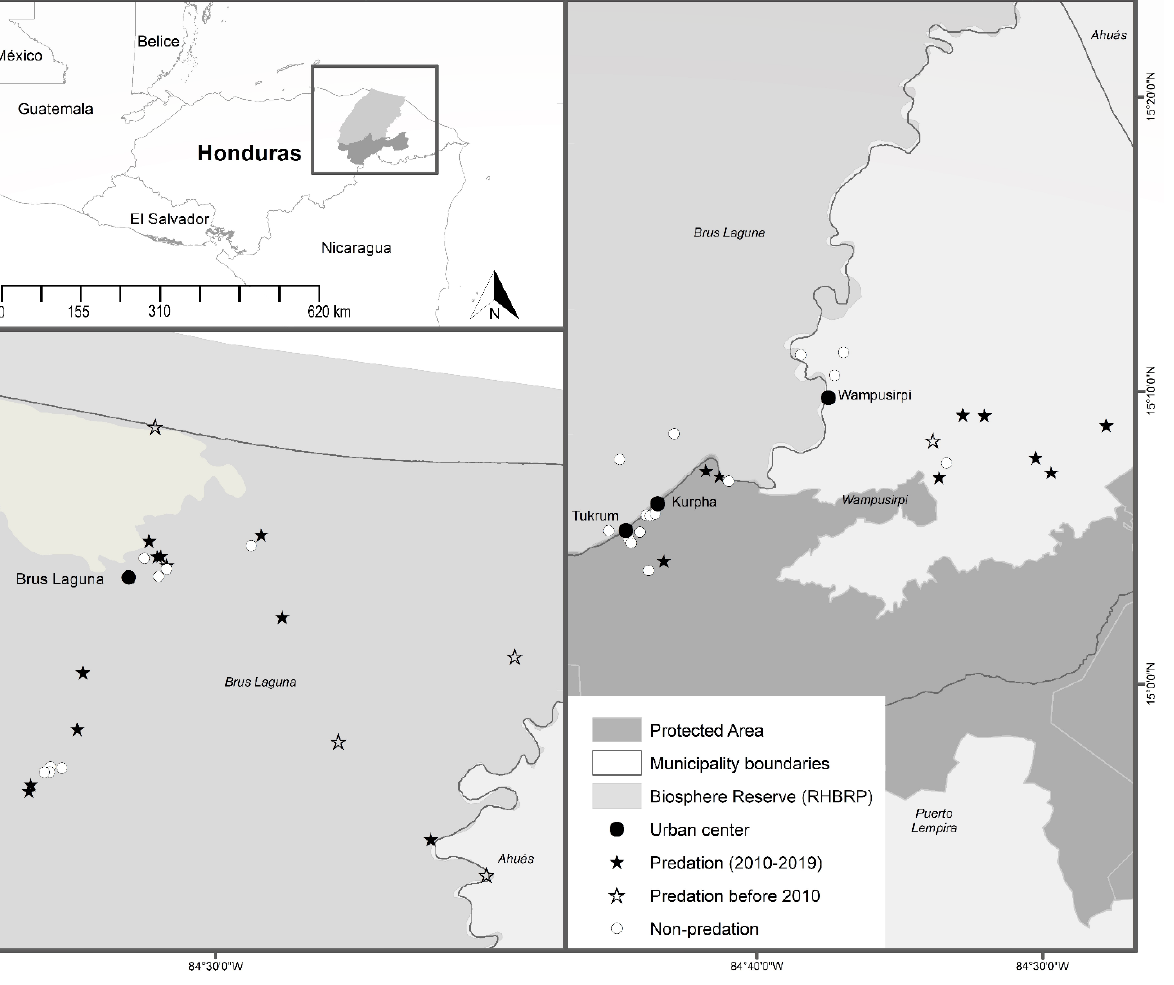
Figure 1. The study area showing the ranches visited in Brus Laguna and Wampusirpi communities. Black stars correspond to the location of the surveyed ranches that reported predation events between 2010–2019. Open stars correspond to the location of the surveyed ranches that reported predation events before 2010 and the white dots correspond to the location of the surveyed ranches that did not report predation events. Urban centers of communities are represented by black dots.